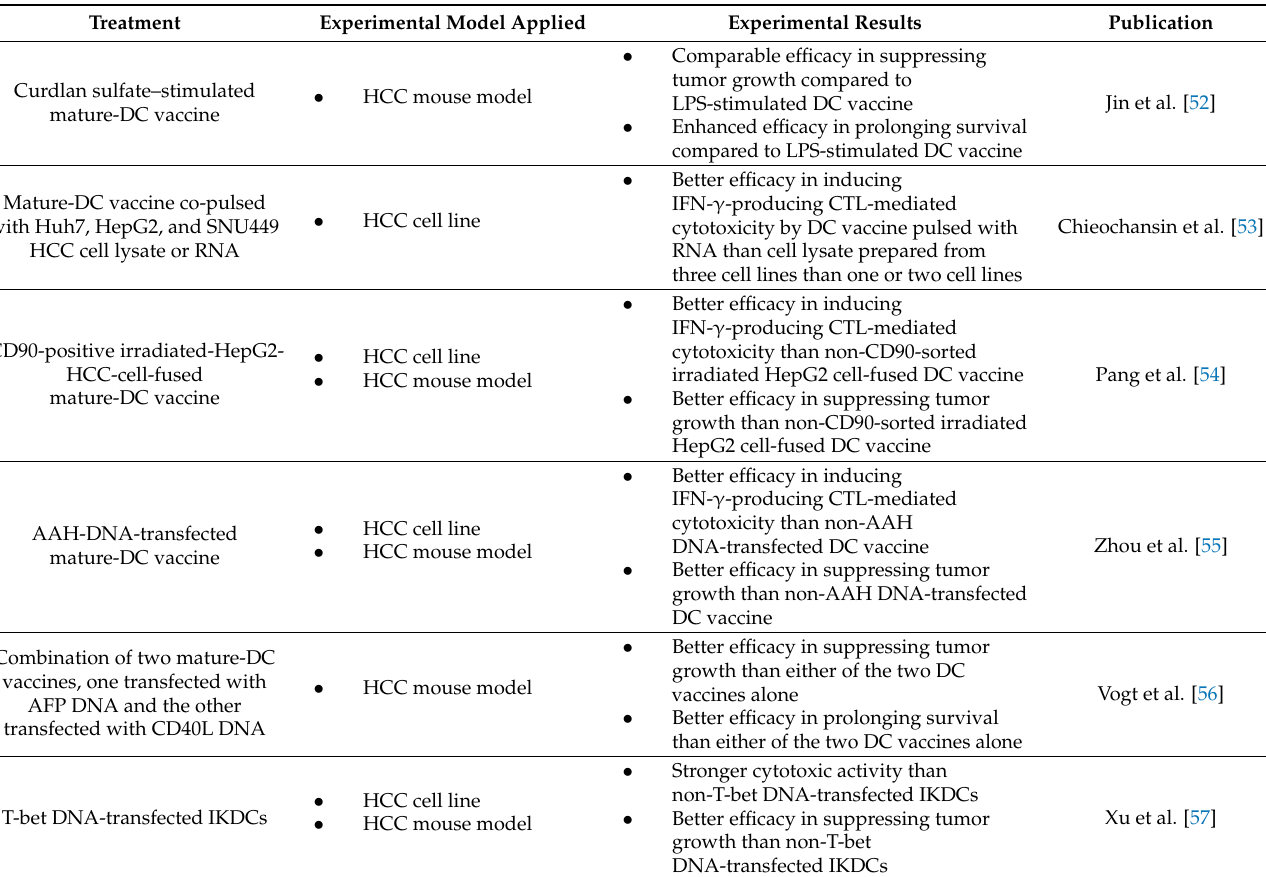
Table 3. Summary of recent preclinical studies regarding DC-vaccine-based immunotherapy for